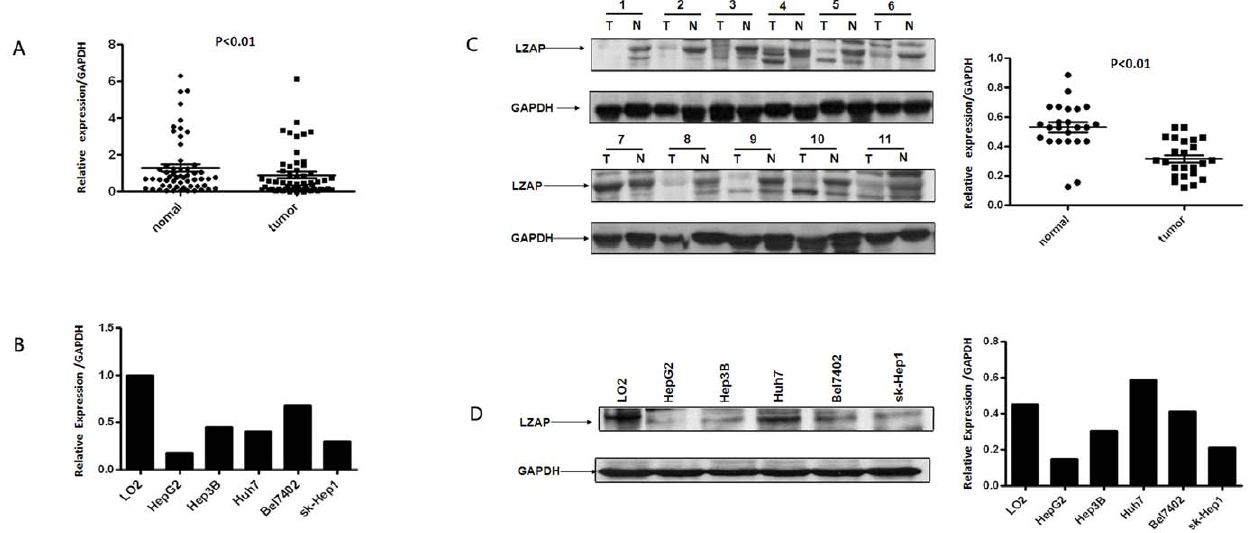
Figure 1. The expression of LZAP mRNA and protein in the human primary HCC surgical specimens and HCC cell lines, as evaluated by real-time quantitative PCR and western blotting. ( A ) The relative mRNA expression of LZAP was lower in 57 HCC tumor tissues than in matched adjacent non-tumorous tissues (p , 0.01). ( B ) The LZAP mRNA expression in human hepatocellular carcinoma cell lines was down-regulated in the HepG2, Hep3B, Huh7, Bel7402 and sk-Hep1 cells, particularly in the HepG2 and sk-Hep1cells, compared with the normal liver cell line LO2. ( C ) The LZAP protein expression was lower in the tumor tissues than in matched adjacent non-tumorous tissues (p , 0.01). ( D ) The LZAP protein levels were significantly lower in the HepG2 and sk-Hep1 cells than in the normal liver cell line